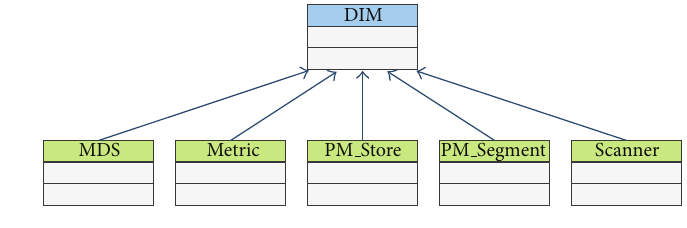
Figure 8: The X73 DIM class diagram.